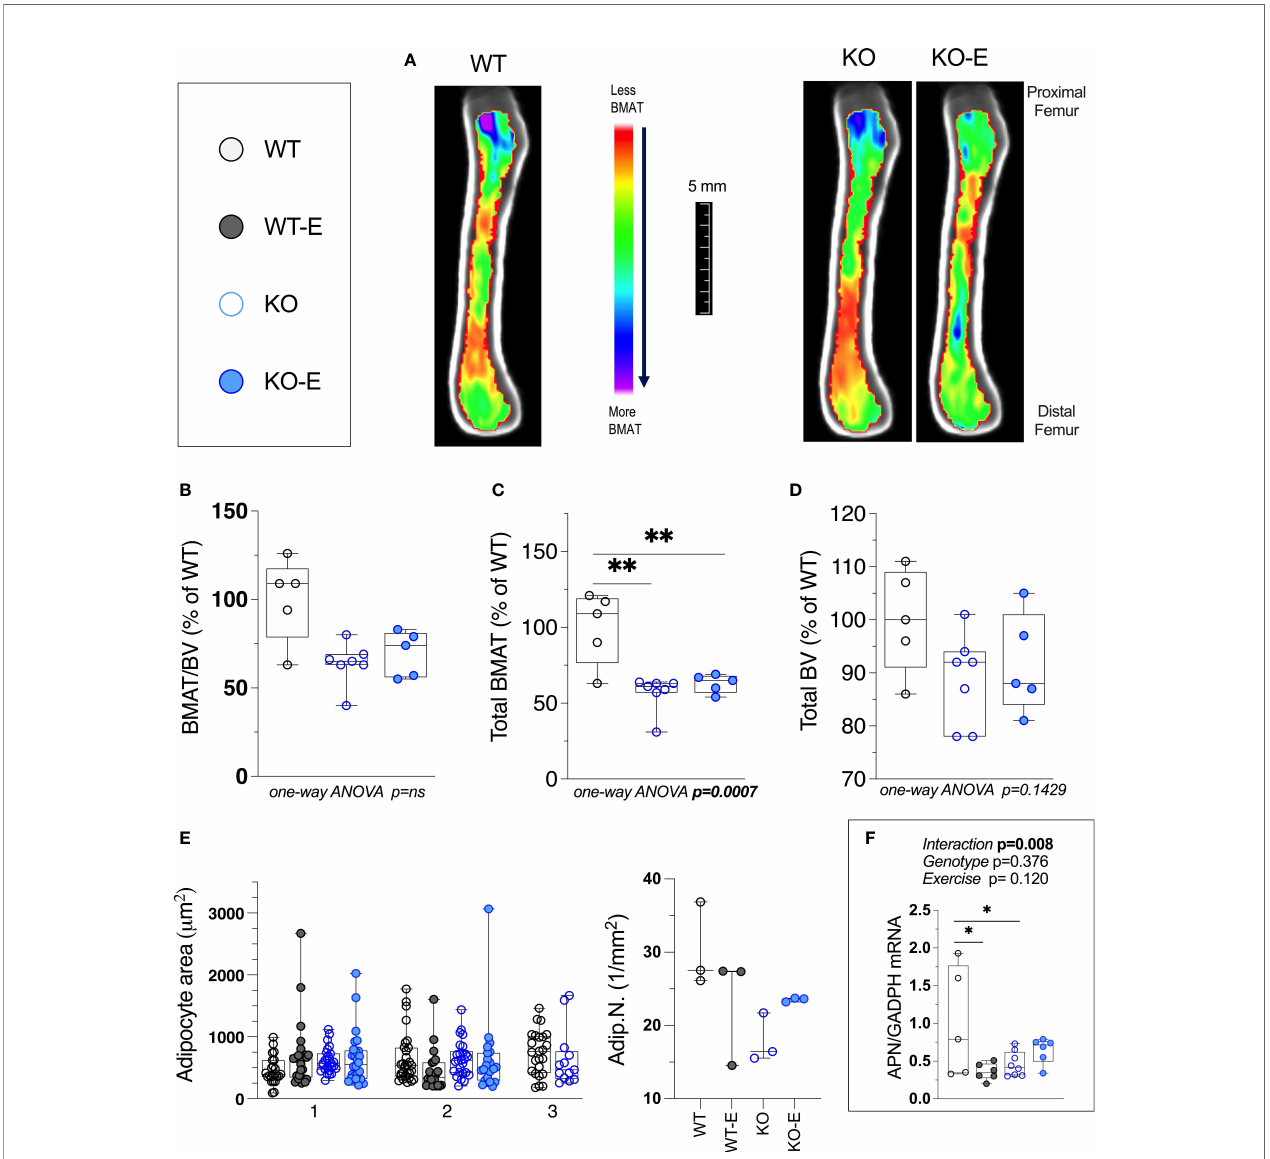
FIGURE 2 | Bone Marrow adipose tissue (BMAT) is extant, but reduced in SEIPIN KO Lipodystrophy. 12-week old male Bscl2 -/- KO allocated to exercise (E) vs non-exercise for 6 wk. compared to WT (A) Visualization of BMAT via 9.4 T MRI with advanced image analysis; each image is an average from superimposed individual images in the sagittal plane. Volumetric quanti fi cation of BMAT form N=5-7 MRI images is shown in (A) . In (B – D) , BMAT values are shown as % relative to WT mean. (B) : Bone Marrow Adipose Tissue /Bone Volume (BMAT/BV). (C) : Total Femoral Bone Marrow Adipose Tissue (BMAT). (D) : Bone Volume (BV). Group differences in (B – D) were analyzed via one-way ANOVA with Tukey's post-hoc test, **p < 0.01. Due to insuf fi cient number of specimens, WTE group was excluded. (E) plot of histomorphometric analysis: adipocyte area (1 m m 2 ) and number (1/mm 2 ), via lmageJ, with X-axis representative of 2-3 experimental animals. For data in (E) there were no signi fi cant differences between groups by nested one-way ANOVA. (F) : Whole tibia adiponectin (APN) mRNA via qPCR (n=5-8 I group) via 2-way ANOVA, Tukey's post hoc , between-group *p < 0.05. Data as individual values on box and whisker plots (min to max). Horizontal lines represent